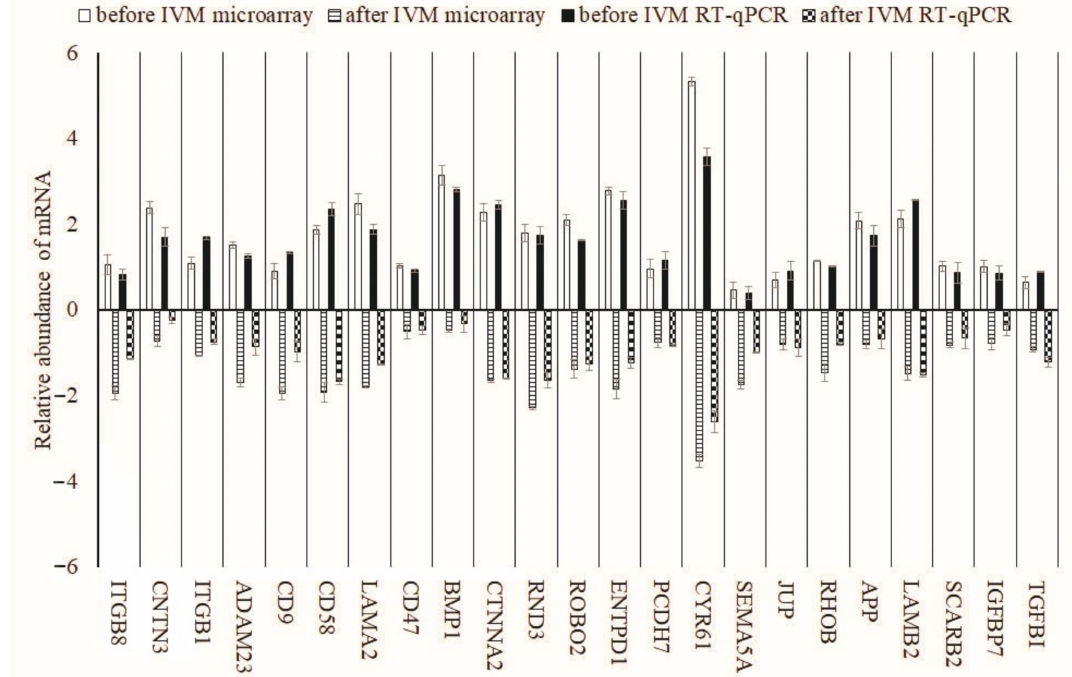
Figure 6. Validation of microarray data by RT-qPCR. Comparison of gene expression analysis of oocytes before in vivo and matured in vitro using microarray and RT-qPCR. RT-qPCR analysis was normalized to the expression of two housekeeping genes ( PBGD and ACTB